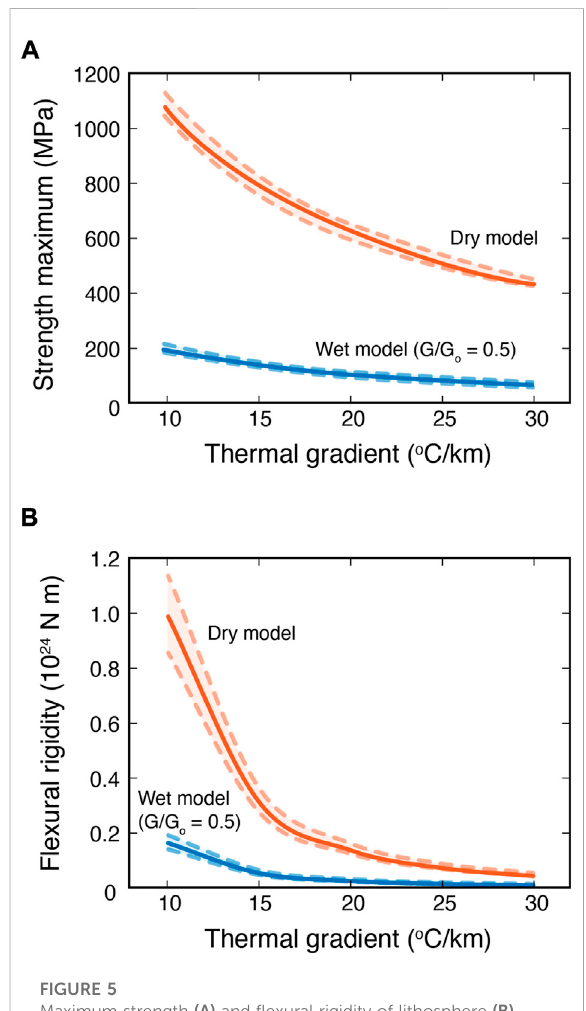
FIGURE 5 Maximum strength (A) and fl exural rigidity of lithosphere (B) calculated in the dry and wet models as shown in Figure 4. In the wet model, the shear modulus was assumed to be half that of the dry model. Solid lines represent calculations using a strain rate of 10 – 16 s − 1 , and dashed lines show variations in strain rates between 10 – 15 and 10 – 17 s − 1